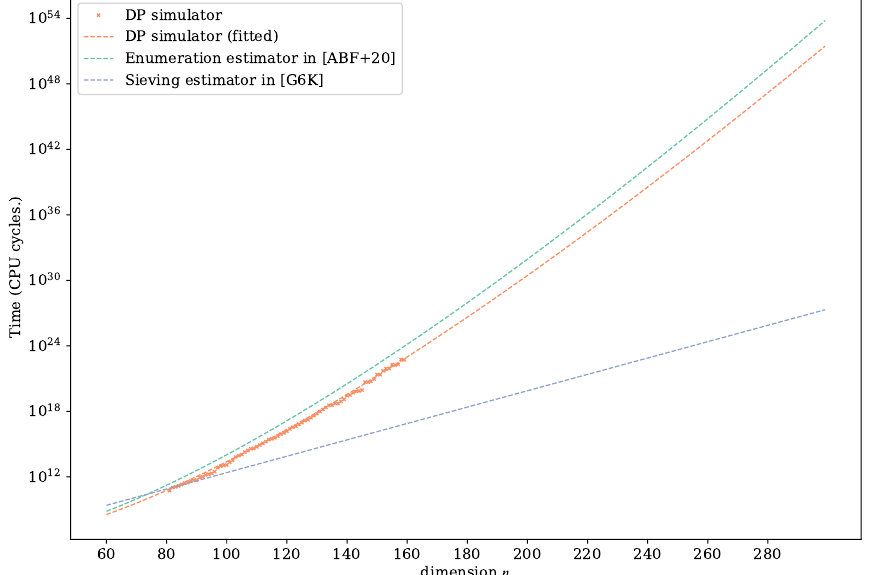
Figure 11. The asymptotic behavior of DP enumeration and other SVP